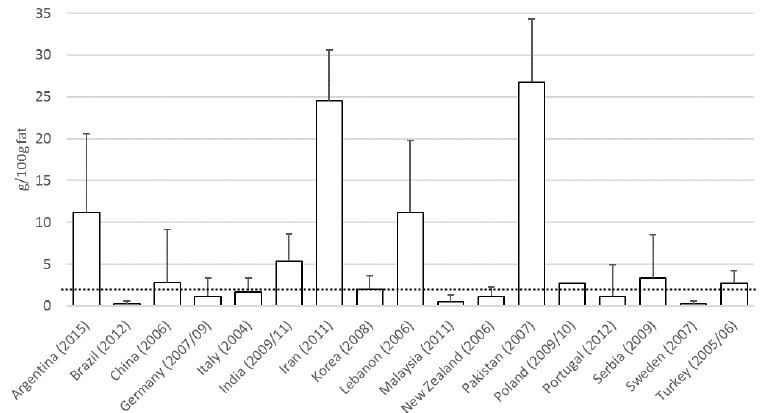
Figure 3. Mean (Standard Deviation) trans fat content of biscuits in 17 countries. Data reported by year of sampling. The dotted line represents the Danish regulatory limit for foods of less than 2 g trans fat per 100 g total fat.